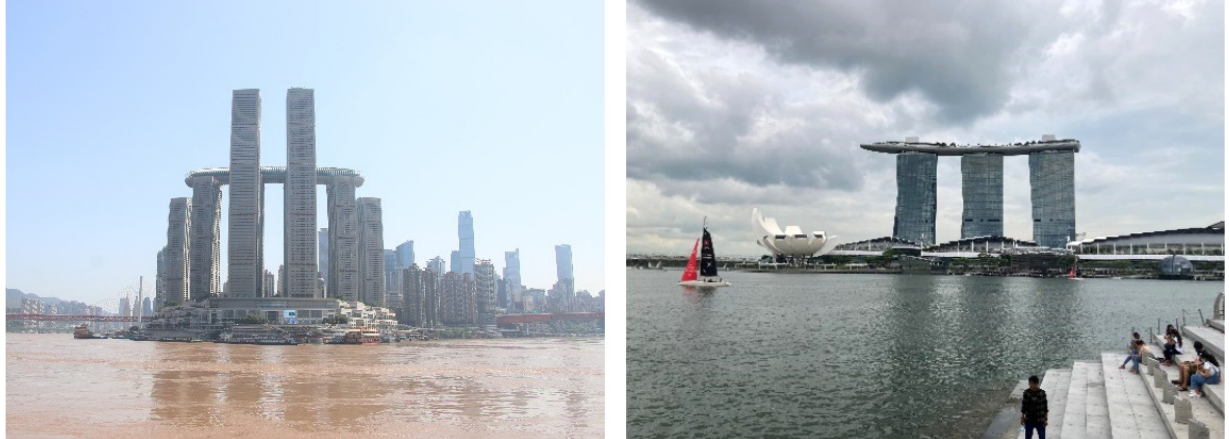
Figure 5. Raffles City Chongqing (left) and Marina Bay Sands, Singapore